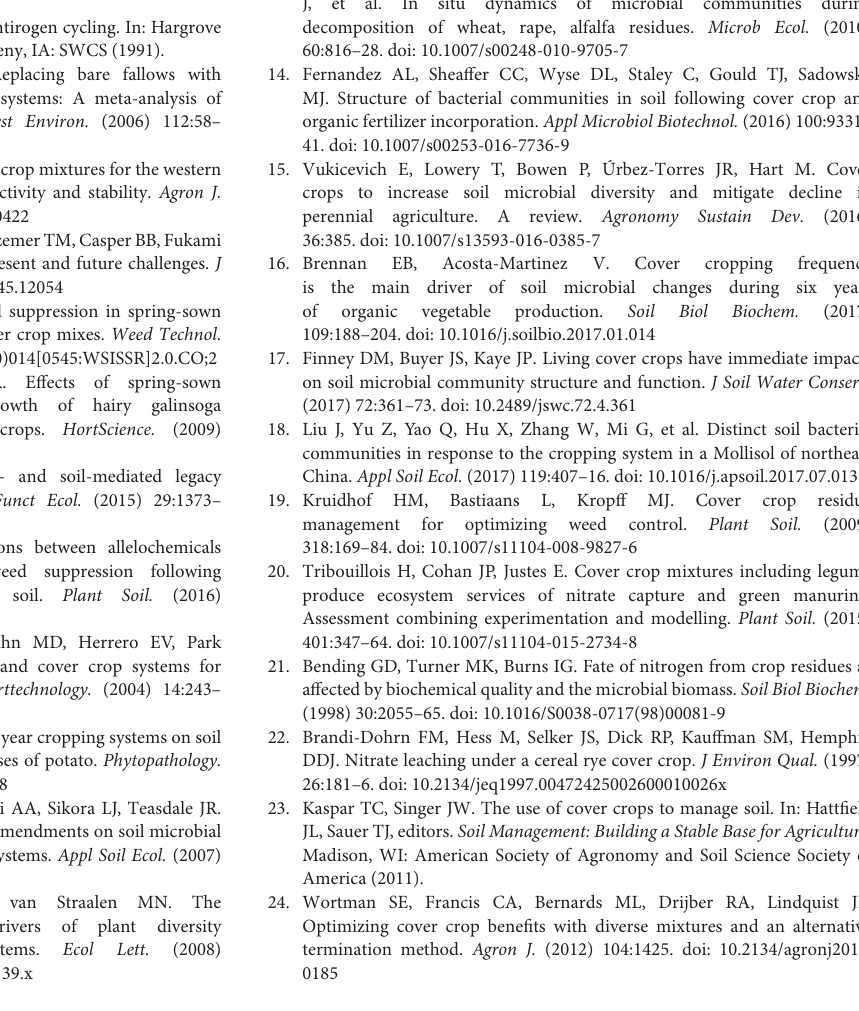
Supplementary Figure 1 | NMDS plot of bacterial communities representing all cover crop treatments. Each point represents a single sample and the bacterial community from that sample. Due to the significant effects of site and year, points are labeled by their site-year interactions. The Bray-Curtis distance method was used to perform the NMDS, with a stress level of 0.164. Ellipses represent the 95% confidence interval around the centroid for the given site-year. Supplementary Figure 2 | NMDS plot of fungal communities representing all cover crop treatments. Each point represents a single sample and the fungal community from that sample. Due to the significant effects of site and year, points are labeled by their site-year interactions. Bray-Curtis distances were used to perform the NMDS, with a stress level of 0.214. Ellipses represent the 95% confidence interval around the centroid for the given